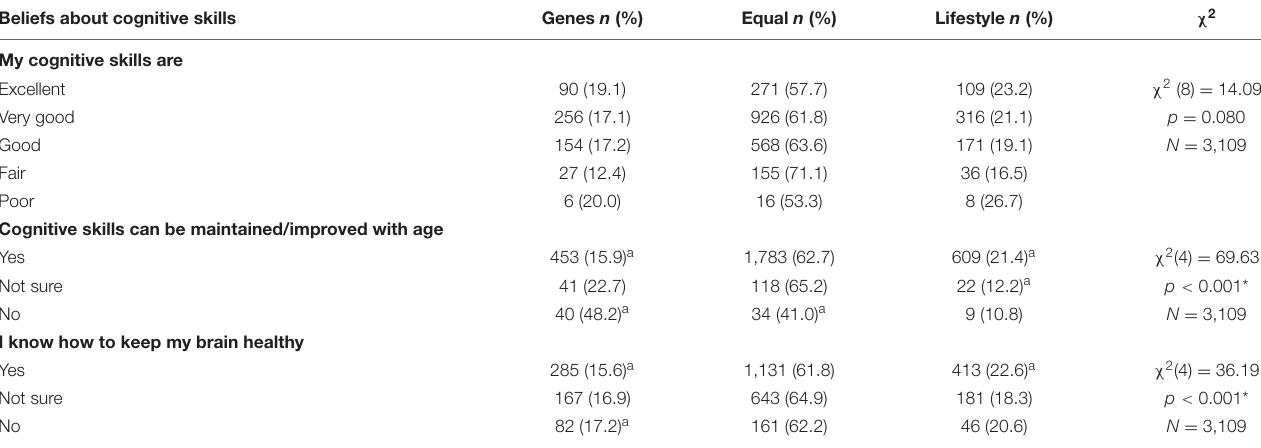
TABLE 2 | Chi-square tests examining respondents’ beliefs about cognitive skills according to their opinions about determinants of those skills. Beliefs about cognitive